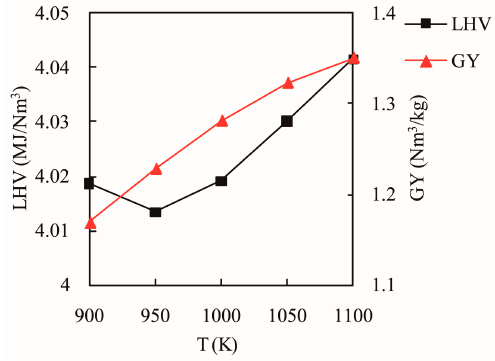
Figure 10. Effects of gasification temperature on LHV and GY at ER = 0.4 and SBR = 0.5.